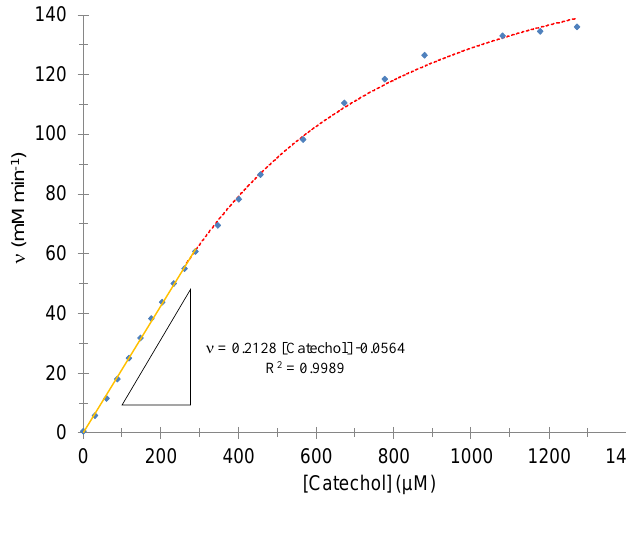
Figure 2. Enzymatic kinetics for catechol using mushroom tyrosinase in solution, in 0.1 M acetates’ buffer at pH 4.50 ± 0.01 and at (30.0 ± 0.5) °C. Monitoring the enzymatic reaction rate as a function of the catechol’s concentration; the dots are the experimental data while the line is the result of fitting the Hill’s model Equation (1) to the data, using the values of K = (0.46 ± 0.02) mM,  = (174 ± 4) mM min −1 and h = 1.33 ± 0.04. The m max linear fit of the trace and its corresponding equation are also shown in the